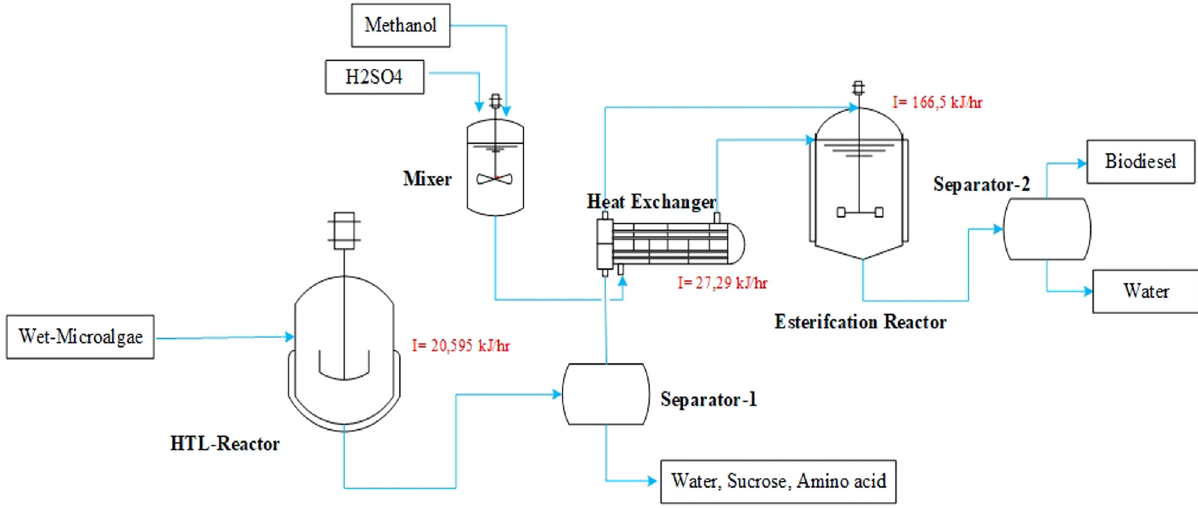
Figure 4: Biodiesel production process fl ow diagram of HTL - esteri fi cation